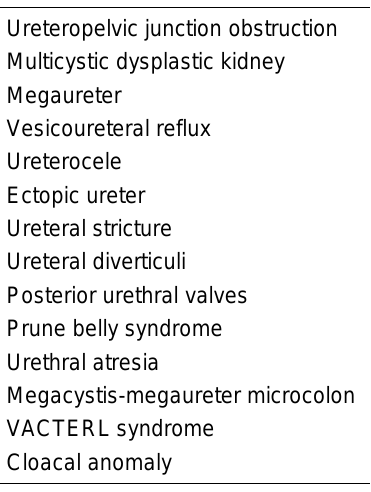
FIGURE 1 . Differential diagnosis of AH.